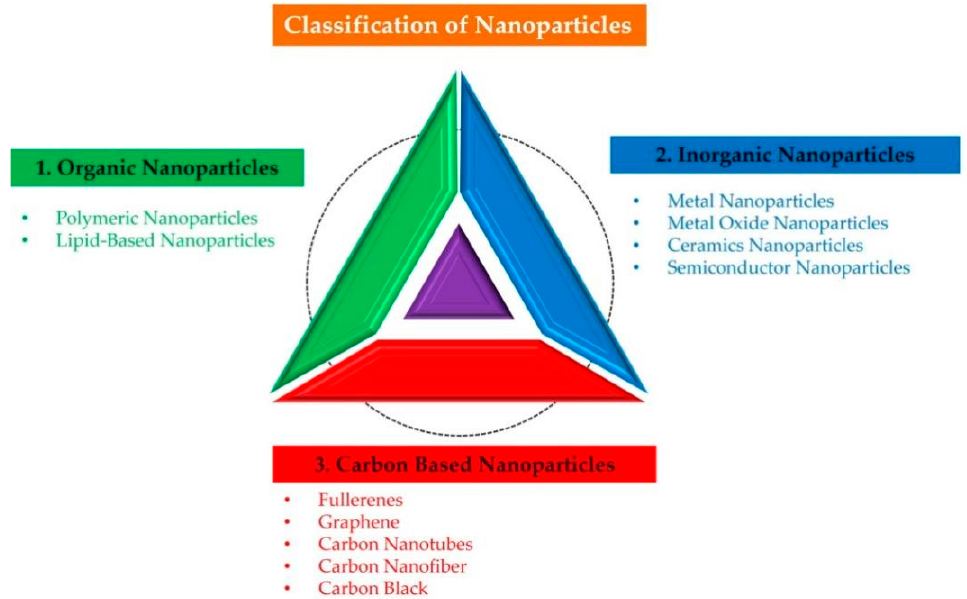
Figure 1. Classification of NPs: (1) organic-origin NPs, containing polymeric NPs and lipid-based NPs; (2) inorganic-origin NPs, containing metal NPs, metal oxide NPs, ceramic NPs, and semiconductor NPs; (3) carbon-origin NPs, containing fullerene NPs, graphene NPs, and carbon NPs (idea adapted from ref [45].